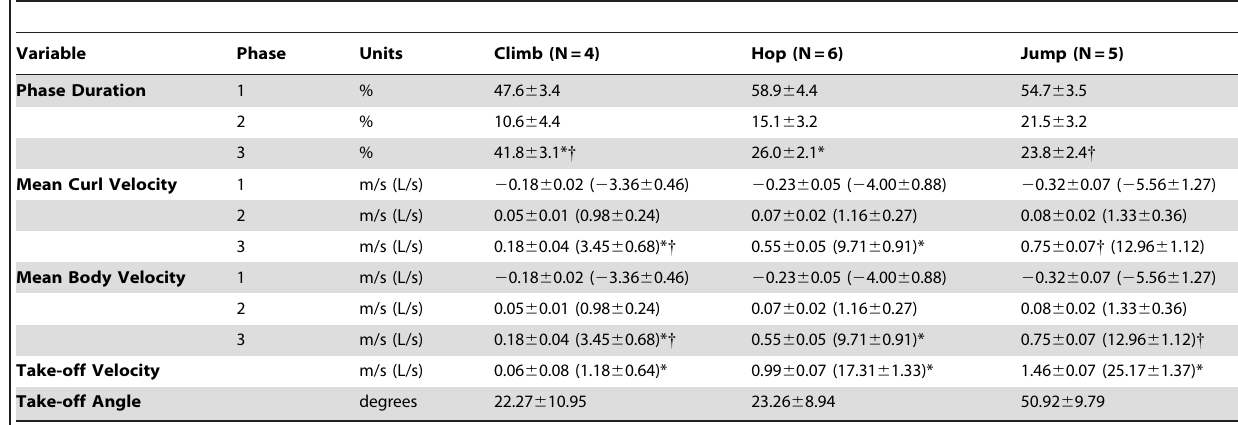
Table 1. Select kinematic variables characterizing climbs, hops, and jumps in the Pacific leaping blenny ( Alticus arnoldorum ).